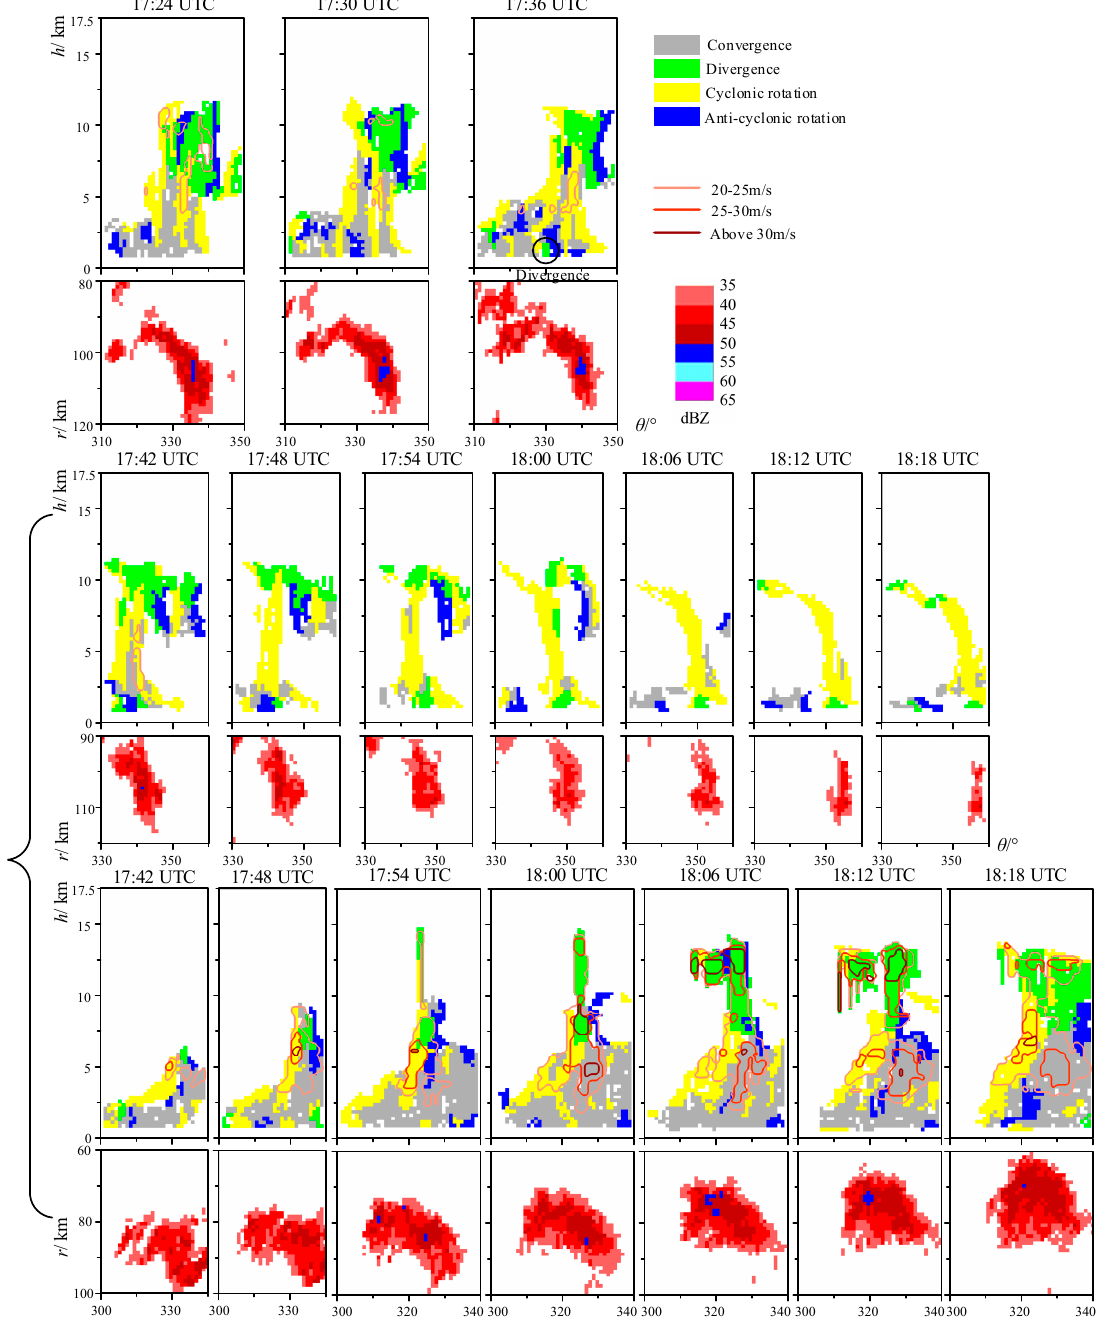
Figure 10. The PMAFSTIs and the corresponding composite reflectivity maps in the θ - r rectangular coordinate system of the event of another cell’s split (30 July 2015).